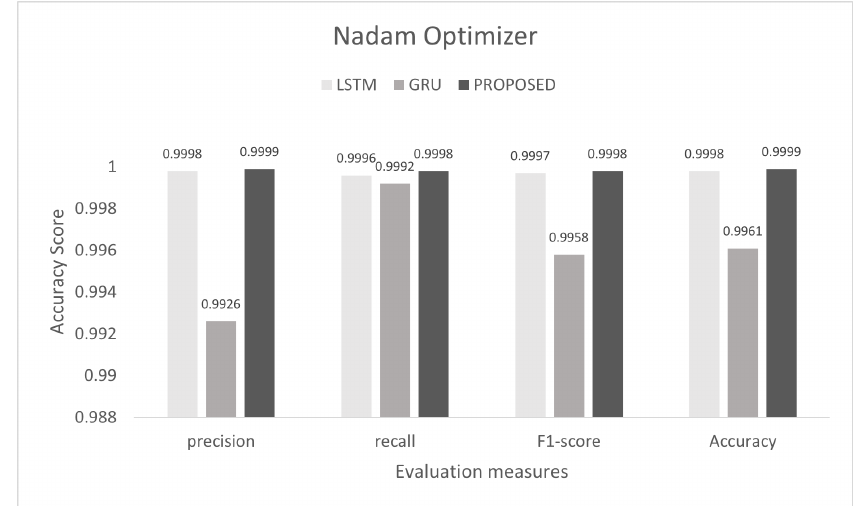
Figure 15. Evaluation on Nadam with the car-hacking dataset.